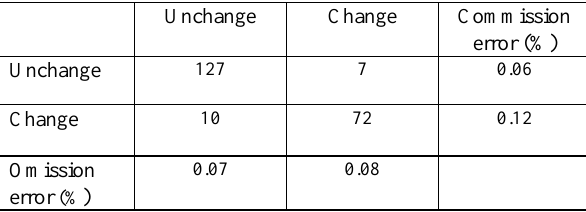
Table 4. ANN’s confusion